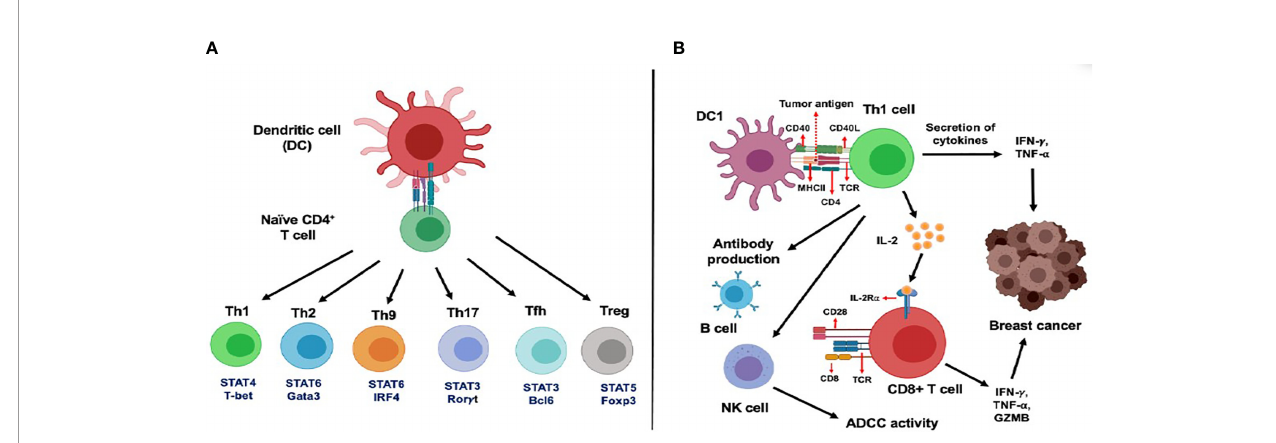
FIGURE 1 | Functional subsets of CD4+ T cells and role of CD4+ T cells in the activation of CD8+ T cells in cancer. (A) Dendritic cells (DC) regulate differentiation and polarization of na ї ve CD4+ T cells into various T helper cells subsets such as Th1, Th2, Th9, Th17, Tfh and Treg cells. (B) DCs primed with tumor antigenic peptides can present the antigens to Th1 cells through the MHC class II molecule. Next, these activated Th1 cells secrete two important Th1 cytokines: IFN- g and TNF- a , leading to direct tumor growth inhibitory effects, mediated by induction of apoptosis, senescence, cell cycle arrest and proliferation arrest. Secretion of IL-2 cytokine from Th1 cells is known to mediate activation and proliferation of IL-2R a expressing CD8+ T cells which leads to enhanced anti-tumor response. In addition, Th1 cells can regulate B cell-mediated antibody production and NK cell-dependent antibody dependent cellular cytotoxicity (ADCC) in